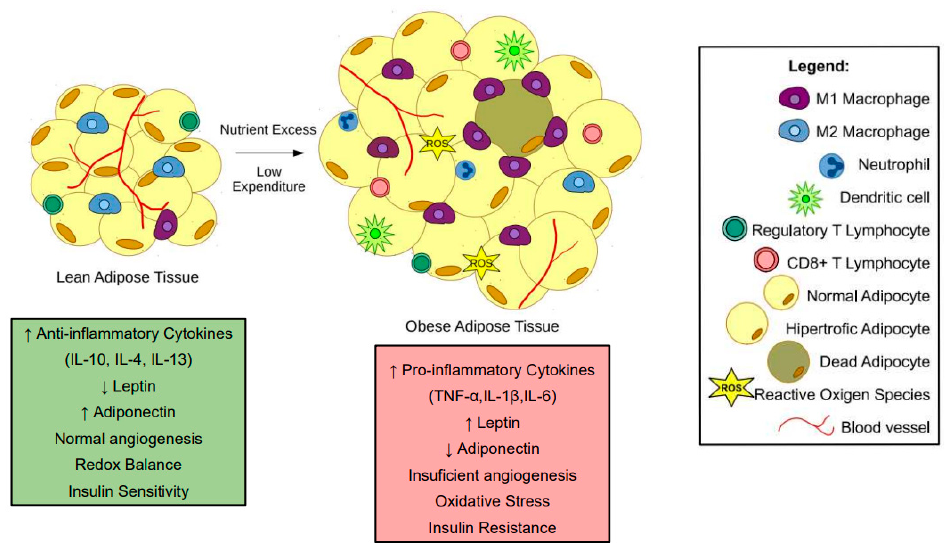
Figure 1. Changes in adipose tissue during obesity. In lean subjects, adipose tissue presents an anti-inflammatory state. Moreover, adipocytes present average triglyceride storage. During obesity, nutrient excess and low expenditure promote a hypertrophic state in adipocytes. The hypertrophic adipocytes and pro-inflammatory immune cells, such as M1-like macrophages, neutrophils, and CD8+ T cells, contribute to a low-grade inflammatory state in subjects with obesity. Most of the pro-inflammatory factors released by obese adipose tissue interfere with bone cells leading to bone loss.